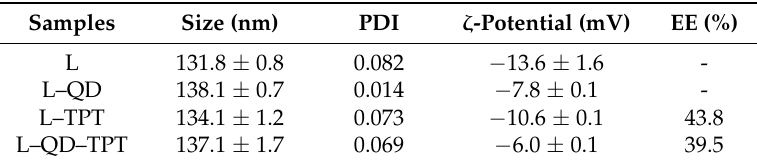
Table 1. Physicochemical properties and EE% of the